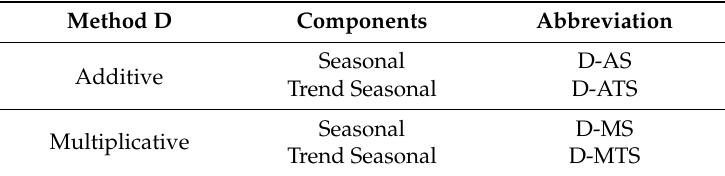
Table 1. Time series decomposition model abbreviations.